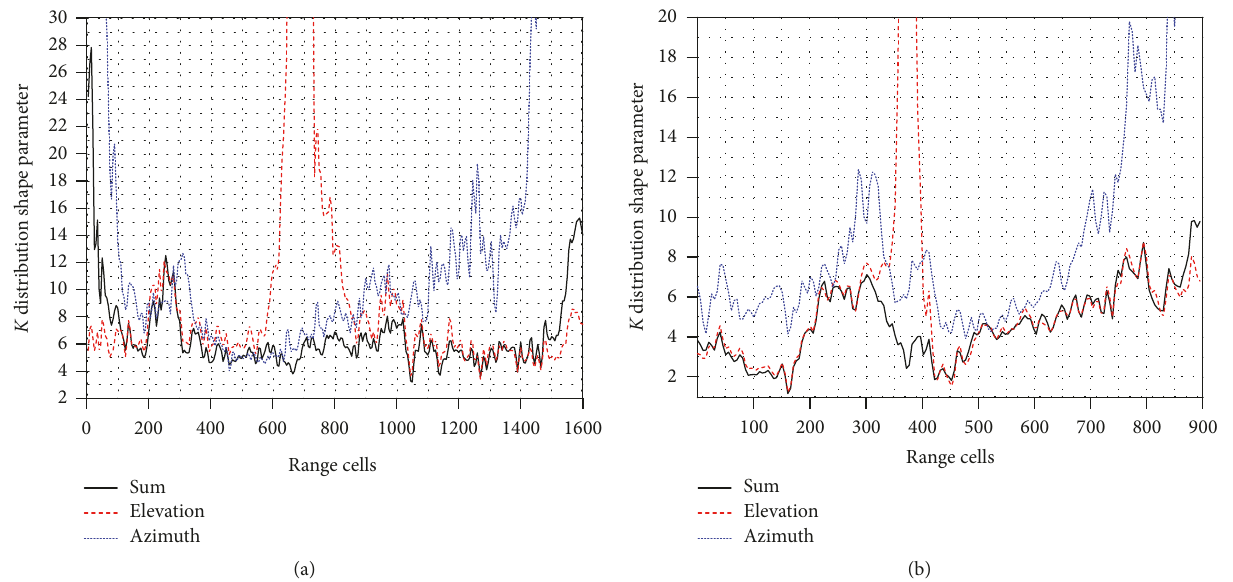
Figure 5: Estimated 𝐾 distribution parameters, where the thermal noise is ignored: (a) shape parameter for DS1. (b) Shape parameter for DS2.